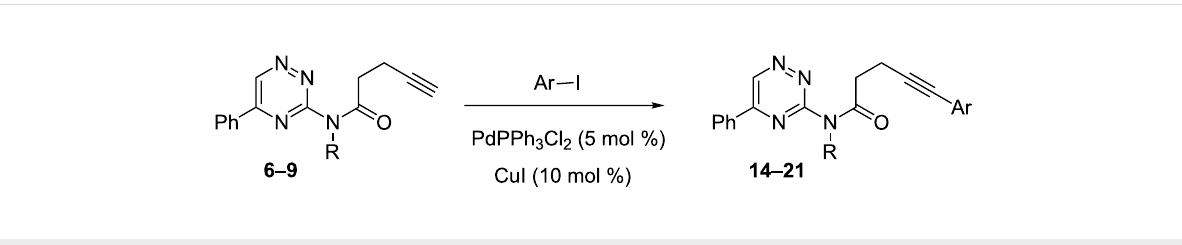
Scheme 5: Preparation of aryl- N -triazinylpentynamides. Conditions: CuI (10 mol %), Pd(PPh 3 ) 2 Cl 2 (5 mol %), DME, Et 3 N, rt, 3 h.